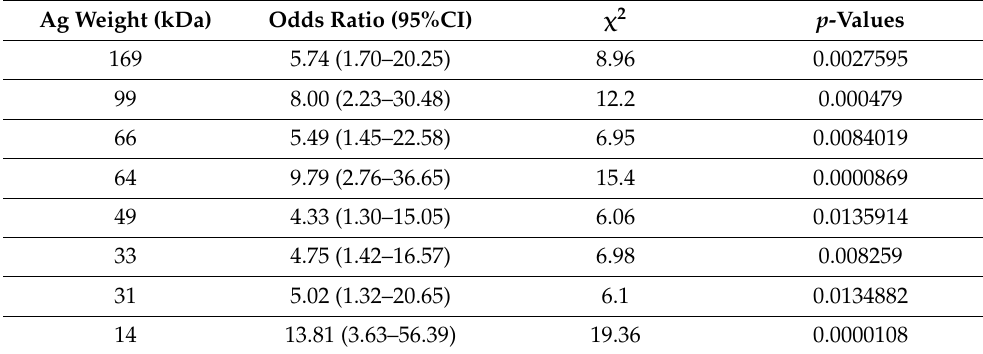
Table 1. Odds ratio values by the Yates chi-square test for eight significant antigen strains of L. infantum .